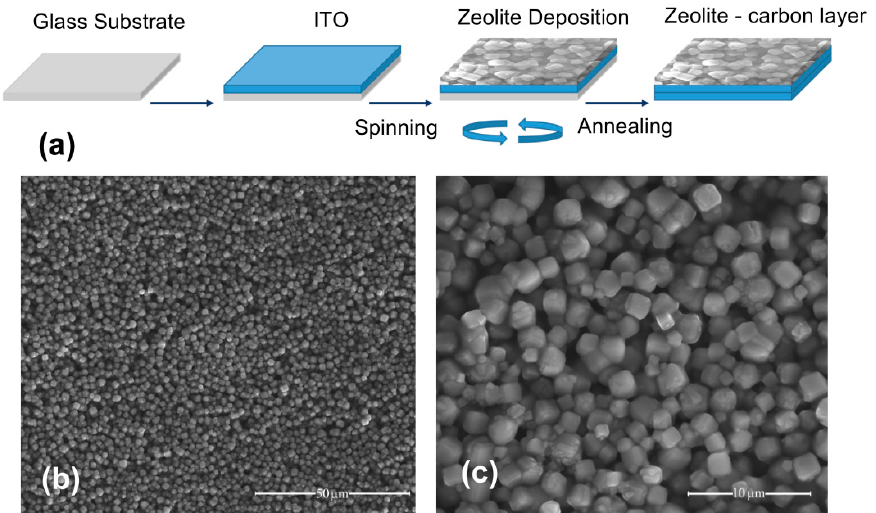
Figure 1. ( a ) Stages of the zeolite 3A deposition onto substrates. SEM surface morphologies for the samples deposited on ( b ) glass (scale bar 50 µ m) and ( c ) ITO / glass (scale bar 10 µ m).